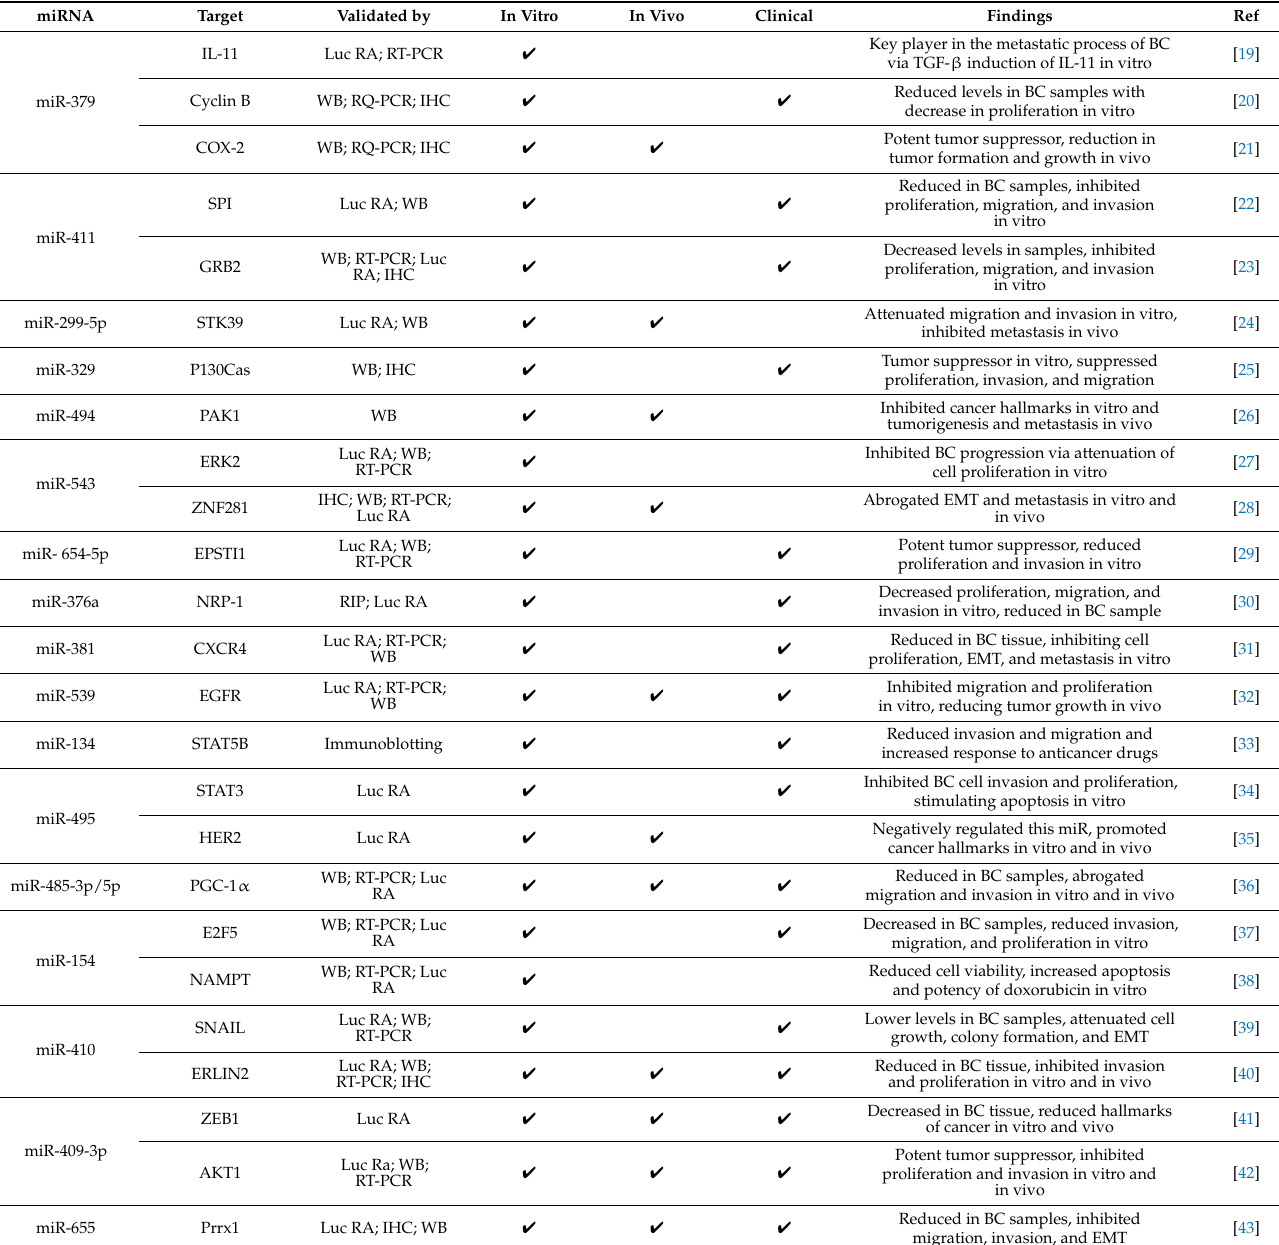
Table 1. Tumor-suppressor miRNAs of the C14MC in breast cancer.